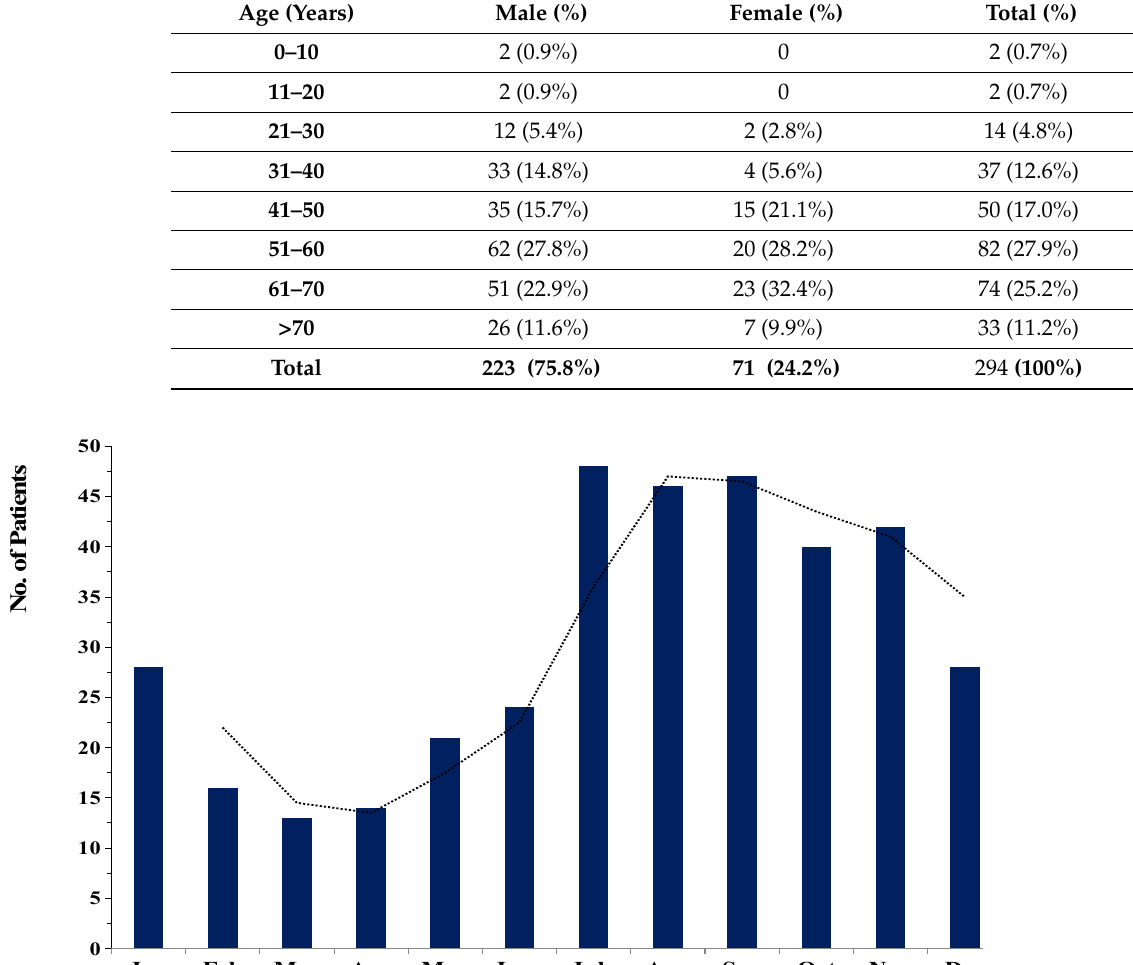
Table 1. Age and sex distribution of mycotic keratitis patients.